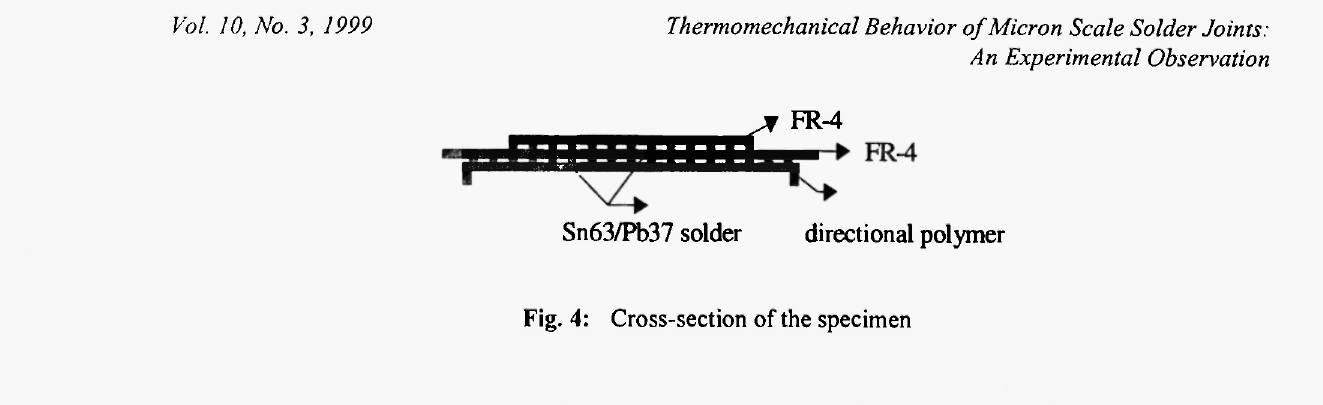
Fig. 4: Cross-section of the